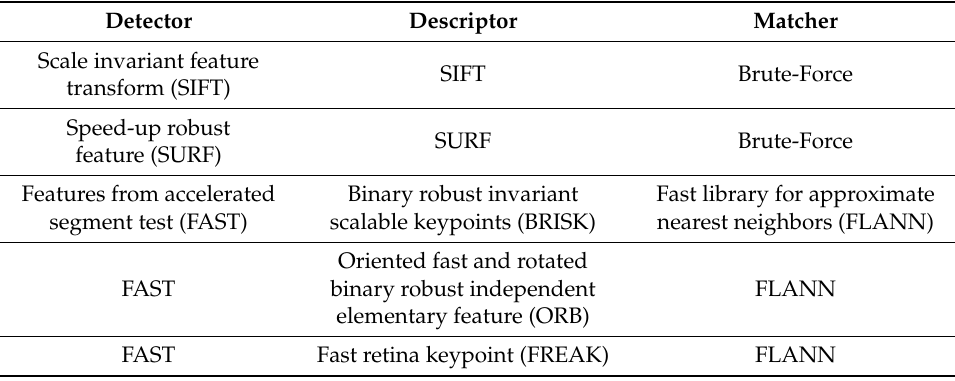
Table 1. The pairwise matching methods tested.